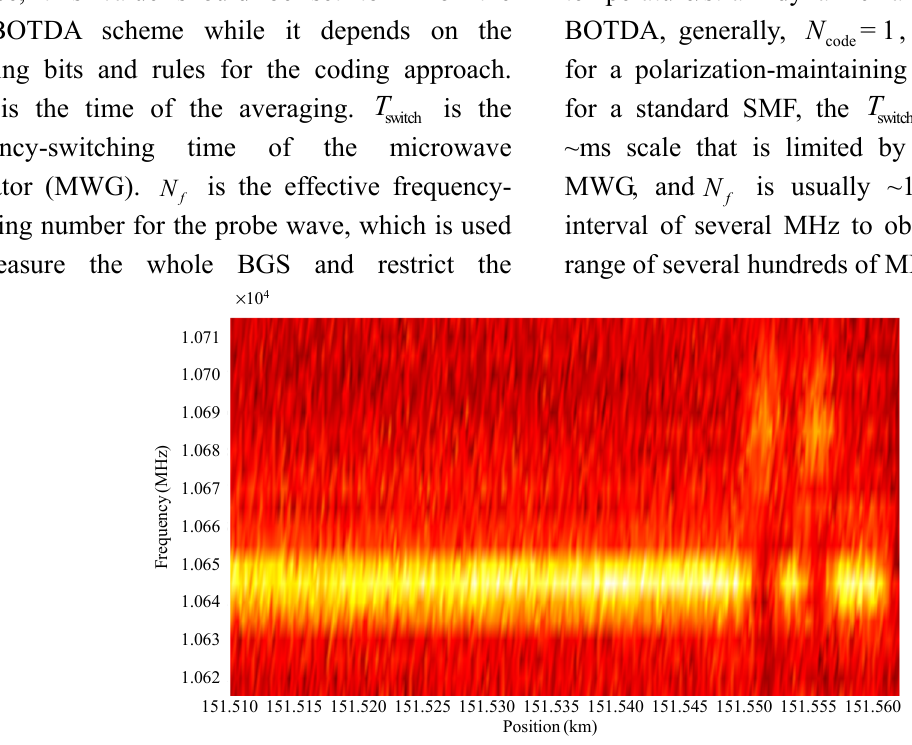
Fig. 9 Measured 3-D Brillouin spectra in the end of the 150-km sensing fiber